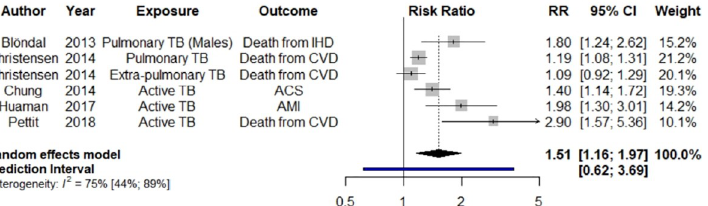
Fig 2. Forest plot of post hoc random effects meta-analysis results for systematic literature review of tuberculosis and risk of cardiovascular disease and related mortality. ACS = acute coronary syndrome, AMI = acute myocardial infarction, CBVE = cerebrovascular event, CI = confidence interval, CVD = cardiovascular disease, IHD = ischemic heart disease, RR = risk ratio, TB = tuberculosis. Black diamond = pooled RR and 95% confidence interval; blue bar = 95% prediction